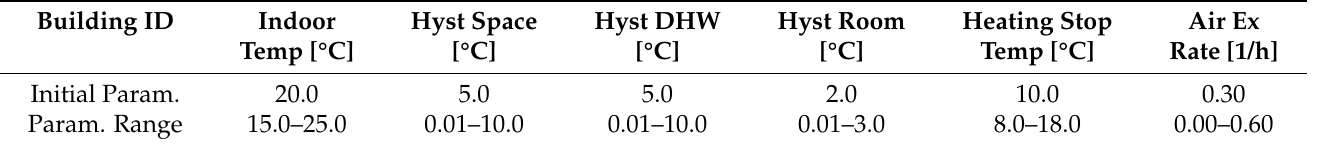
Table 5. Initial model parameter and calibration parameter range.